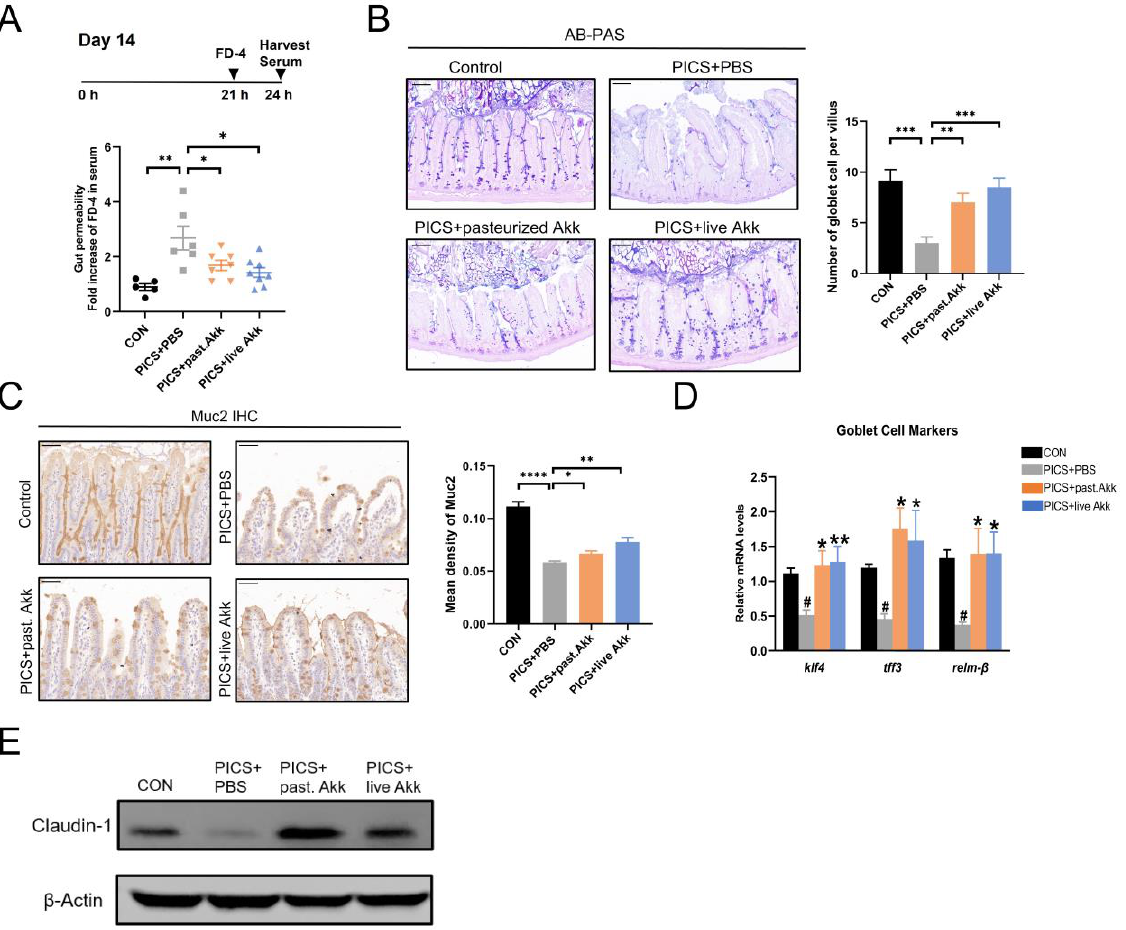
Figure 3. Akk enhanced intestinal mucosal barrier function. ( A ) serum concentration of FD-4 at day 14. ( B ) AB/PAS reaction and the number of acid mucin-producing globlet cells per villus at day 14. Scale bars, 100 µm. ( C ) IHC staining and quantitation of Muc2 in the ileum at day 14. Scale bars, 50 µm. ( D ) Gene expression of goblet cell markers in ileum at day 14. ( E ) Immunoblotting for claudin- 1 in ileum at day 14. past. = pasteurized. Data are shown as the mean ± SEM ( n = 5 mice per group). # p < 0.05, * p < 0.05, ** p < 0.01, *** p < 0.001, **** p < 0.0001. * in comparison with the PICS + PBS